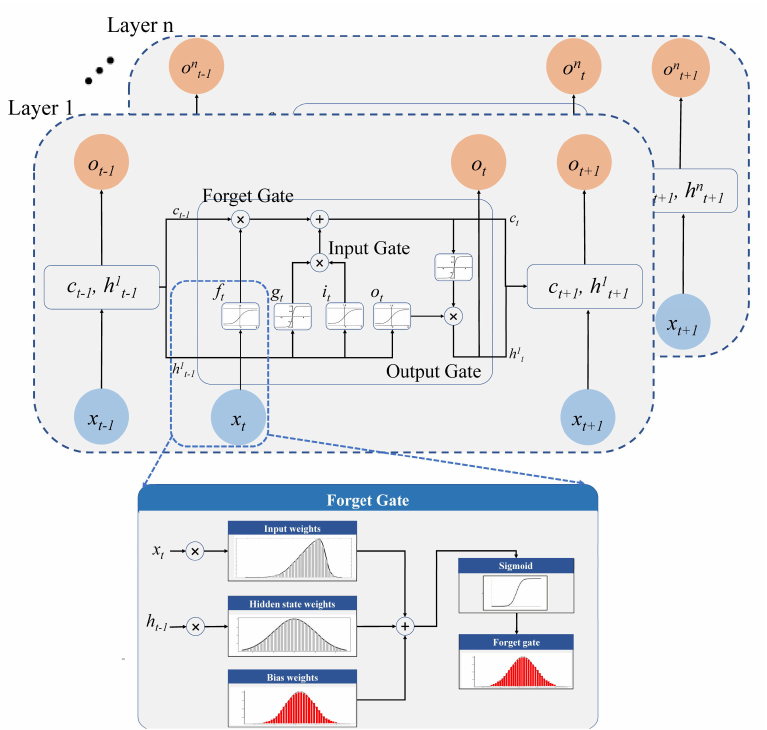
Figure 2. Example of the proposed BLSTM network with a zoomed-in plot of the forget gate at time step t in the first